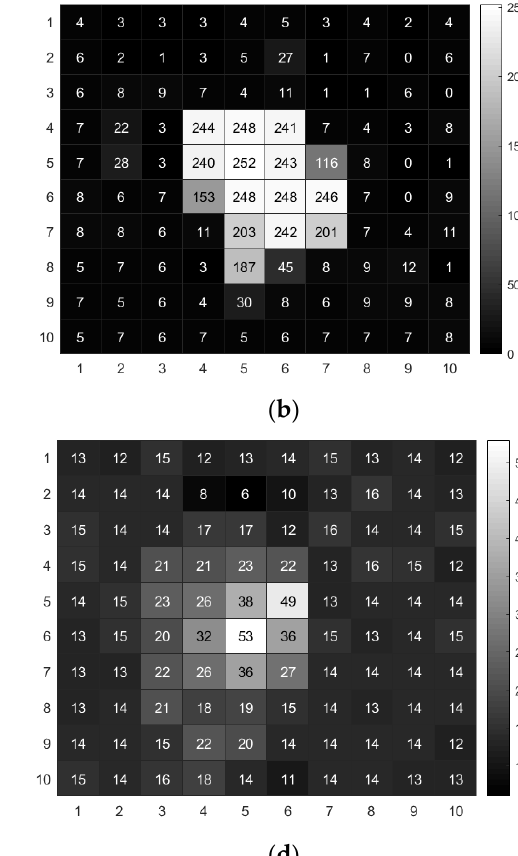
Figure 2. Heatmap of radiation event in a sensor frame. ( a ) 60 Co γ source radiation Event. ( b ) 137 Cs γ source radiation event. ( c ) Am-Be source radiation event. ( d ) 252 Cf source radiation event.